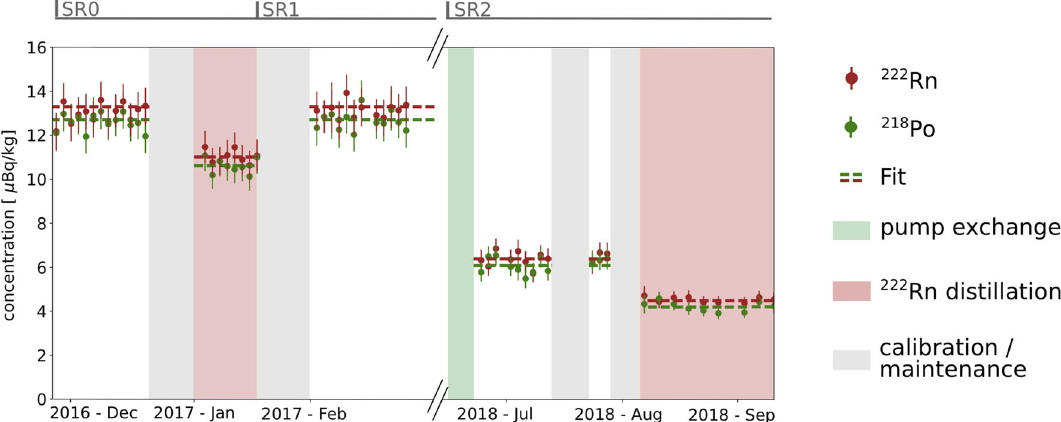
Fig. 3 The activity concentration evolution of 222 Rn and 218 Po during XENON1T data-taking. In science run 0 and 1 (SR0 and SR1) the activ- ity concentrations were stable over the entire time and we only show the initial period here. Xenon distillation campaigns to remove 222 Rn